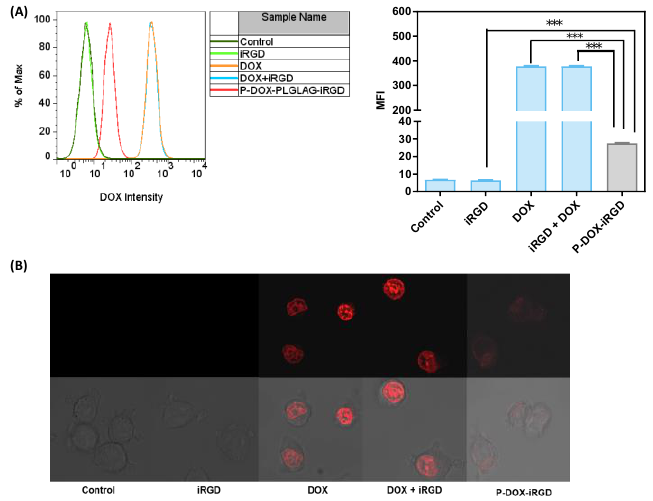
Figure 2. Accumulation of DOX conjugates and controls in 4T1 cells as determined by DOX fluores- cence: ( A ) Flow Cytometry, ( B ) Confocal Microscopy. Data are expressed as mean ± SD, *** p < 0.001.